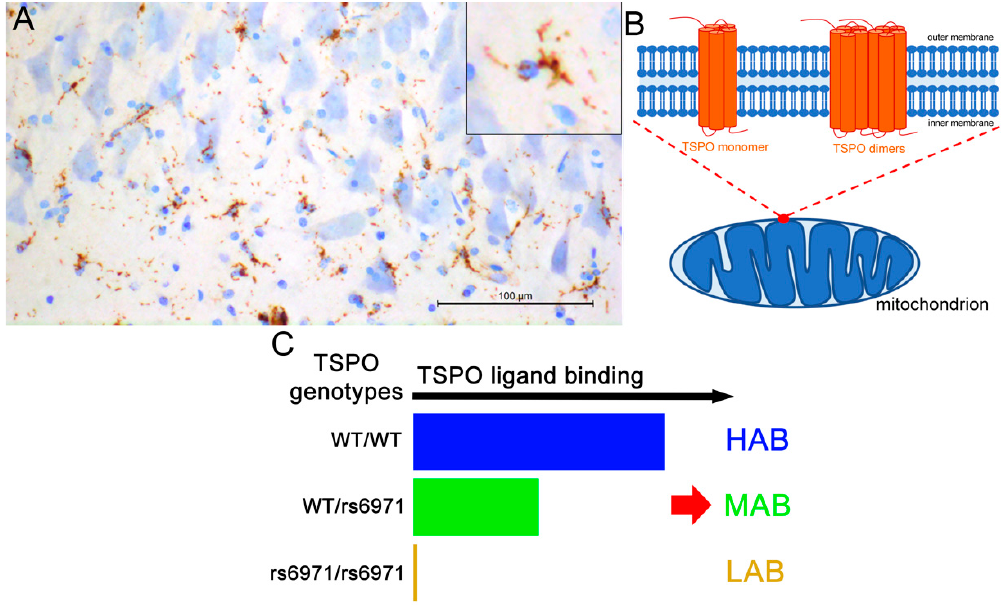
Figure 2. Overview of the 18 kDa translocator protein (TSPO). ( A ) TSPO-immunoreactivity in the human CA1 subregion of the hippocampus. Staining looks like microglial morphology. ( B ) Schematic representation of TSPO monomers and dimers within the mitochondria. Homomultimeric forms exist (not shown). ( C ) Impact of the human TSPO rs6971 polymorphism on TSPO ligand binding and resulting population classification in HAB (high-affinity binder), MAB (mix affinity binder) and LAB (low-affinity binder). Scale bar: 100 μ m.